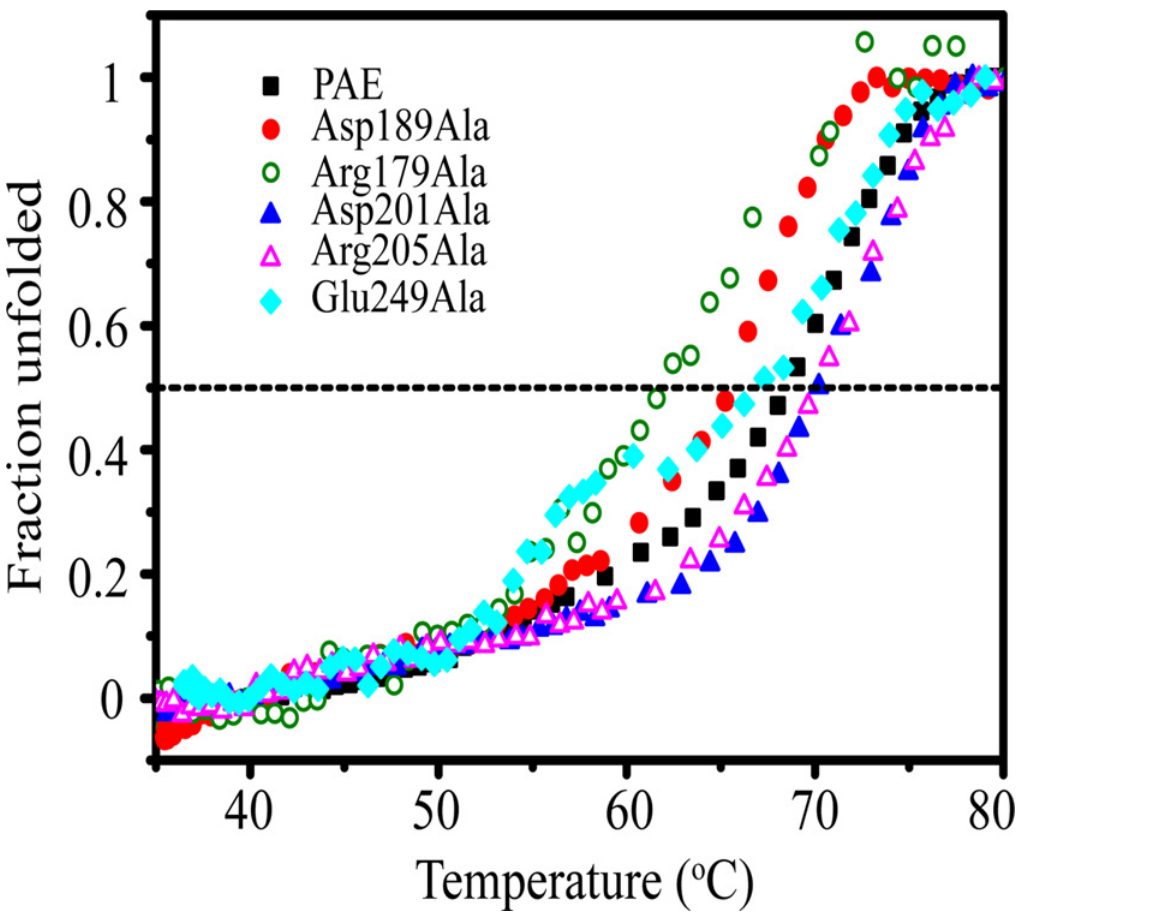
Fig 5. Thermal unfolding of PAE and the active mutants. The dashed line indicates an unfolded fraction of